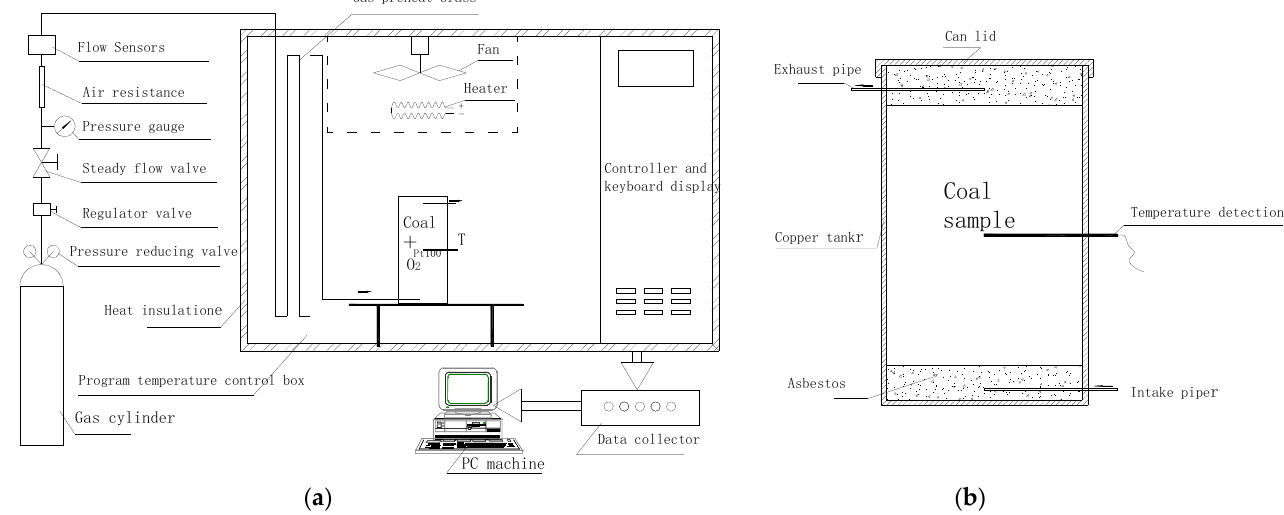
Figure 1. Temperature programming oxidation system. ( a ) Test system; ( b ) heat transfer coal sample tank.